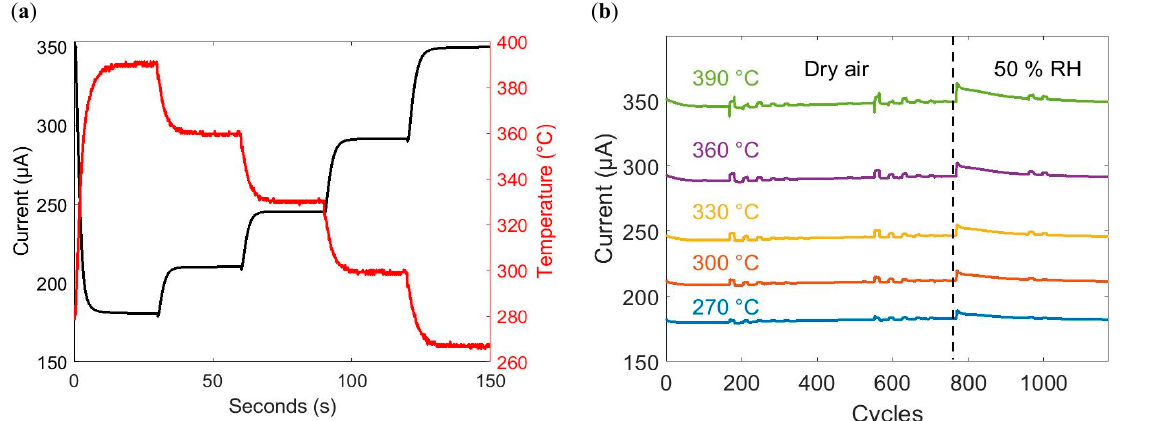
Figure 1. ( a ) Temperature cycle and resulting sensor signal. ( b ) Virtual sensors working at different temperatures extracted from the sensor